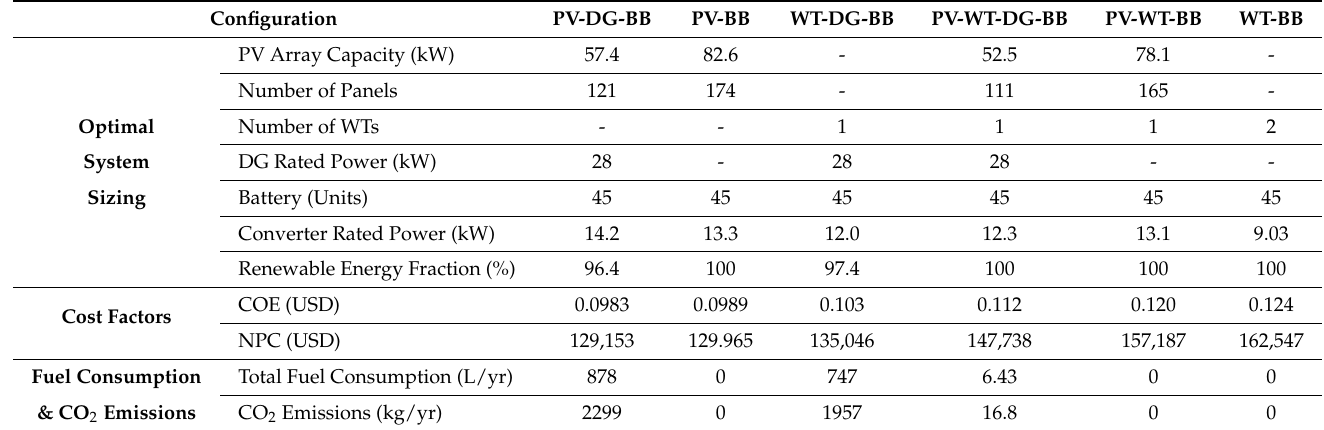
Table 18. Simulation Results for Wafra Cell Site—Case